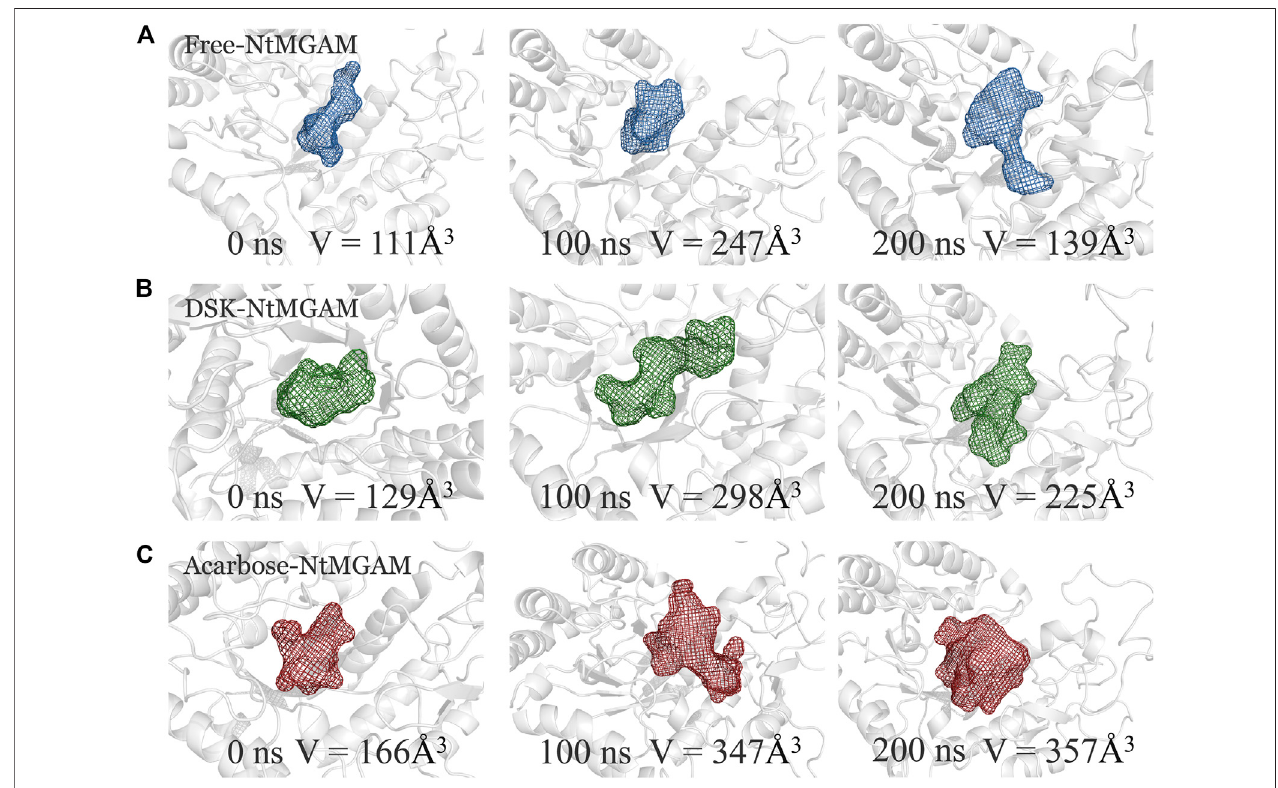
FIGURE 7 | The binding pocket conformations of free-NtMGAM (A) , DSK-NtMGAM (B) , and acarbose-NtMGAM (C) at 0, 100, and 200 ns with the volume of the pockets labeled.